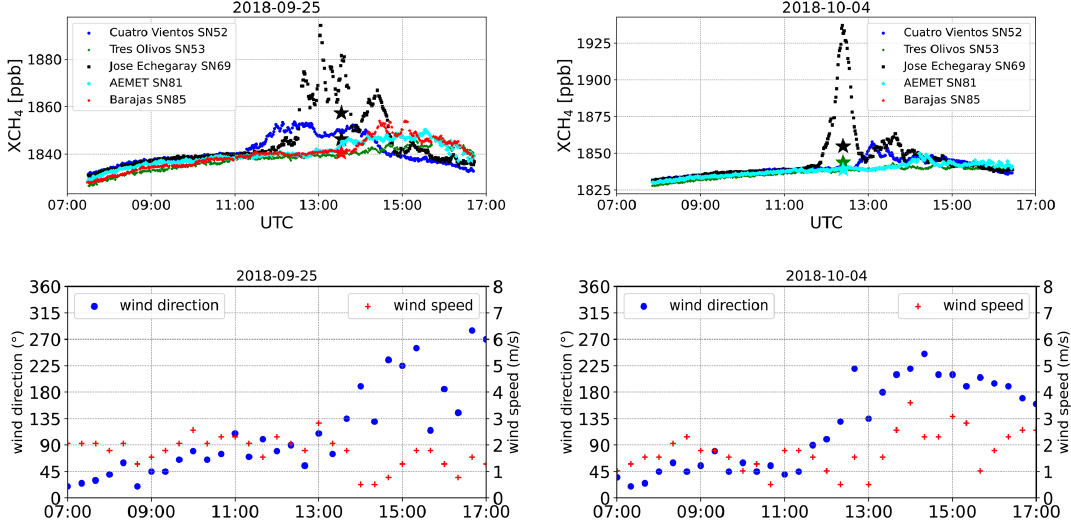
Figure 4. Time series of COCCON measurements at five stations on 2d in 2018. Star symbols represent the averaged TROPOMI observations within a radius of 5km around each station. Lower panels show the wind direction and wind speed measured at the Cuatro Vientos Airport. Table 2. CH 4 emission rates in three waste treatment and disposal plants in Madrid from PRTR. Waste treatment and Valdemingómez Pinto Alcalá Total disposal plants (molec.s − 1